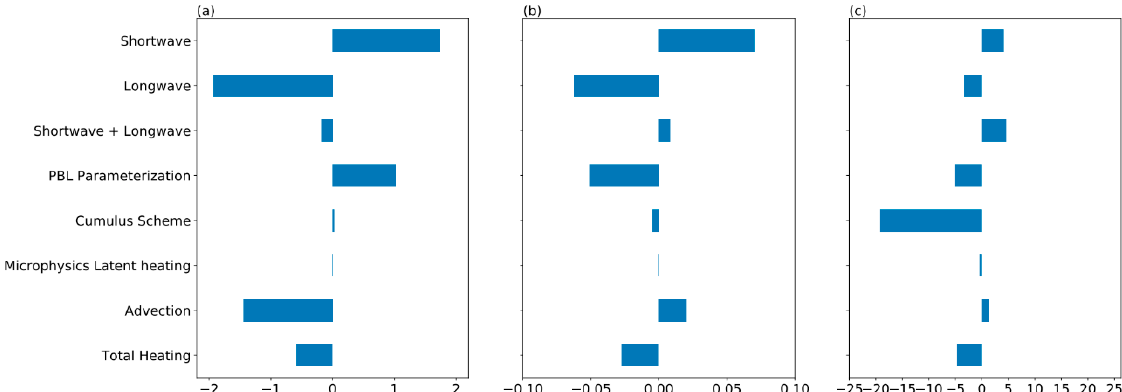
Figure 9. The heating tendencies (K/day) from different processes, averaging over the domain (indicated in Figure 1a) and vertical levels from 1300 UTC 21 to 0000 UTC 23 August 2010. The heating tendencies are from ( a ) ExO, ( b ) the difference (ExDO − ExO), and ( c ) the percentage difference (100 * (ExDO − ExO)/ExO)).